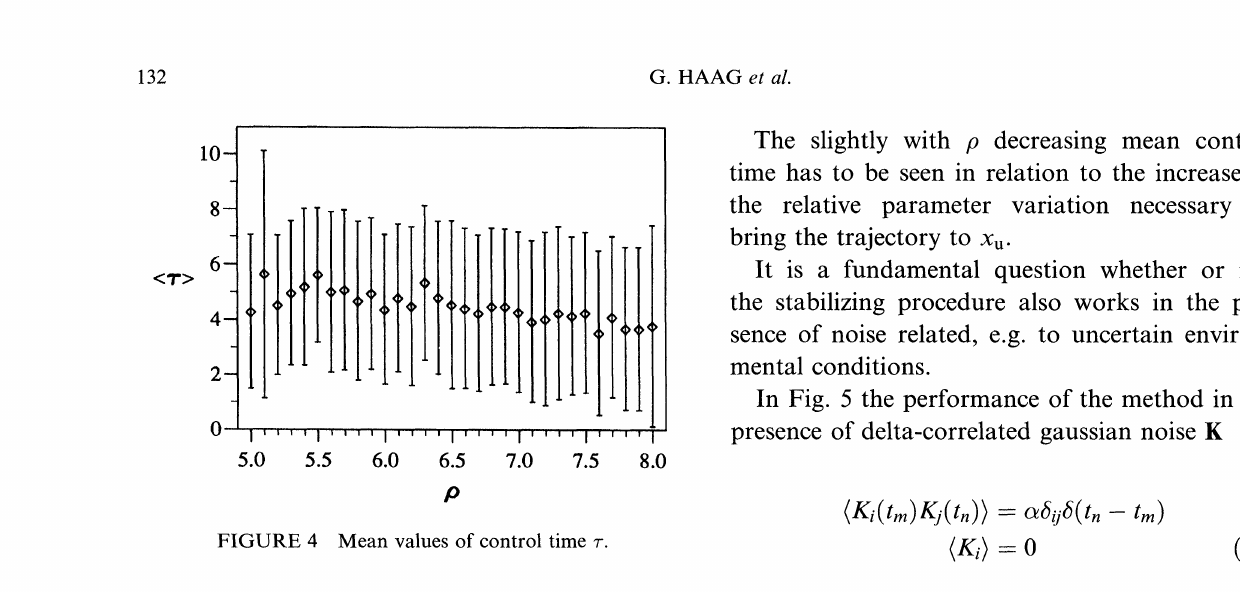
FIGURE 4 Mean values of control time -.